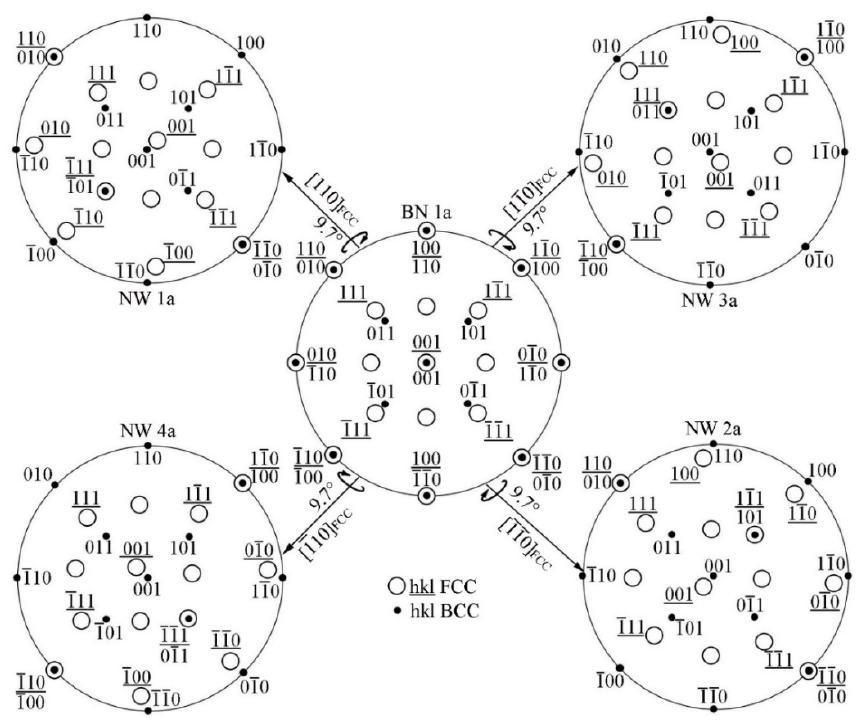
Figure 4. Schematic diagram showing BN 1a transferred to four NW OR variants by rotation axis.